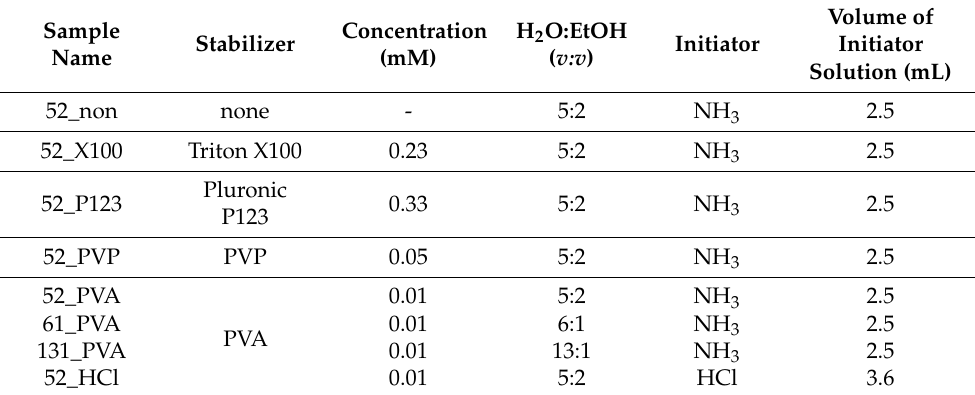
Table 6. Composition of the reaction mixtures used in the syntheses of resol